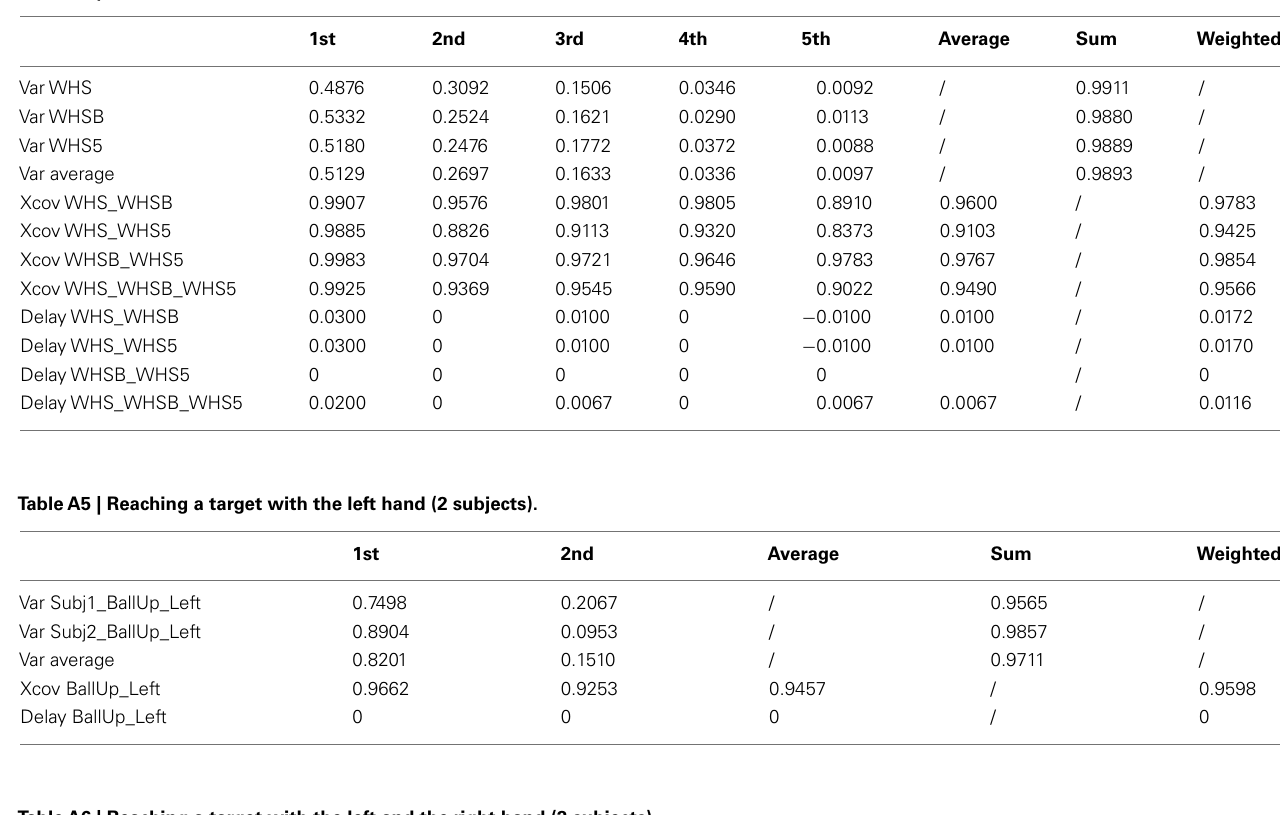
TableA4 |Walking with no constraint, holding an empty box and holding a 5 kg load kMPs (3 subjects).